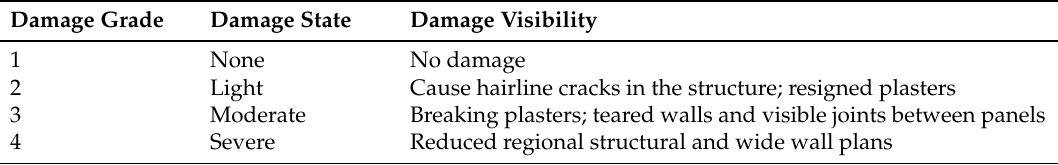
Table 3. Damage classification (adopted from